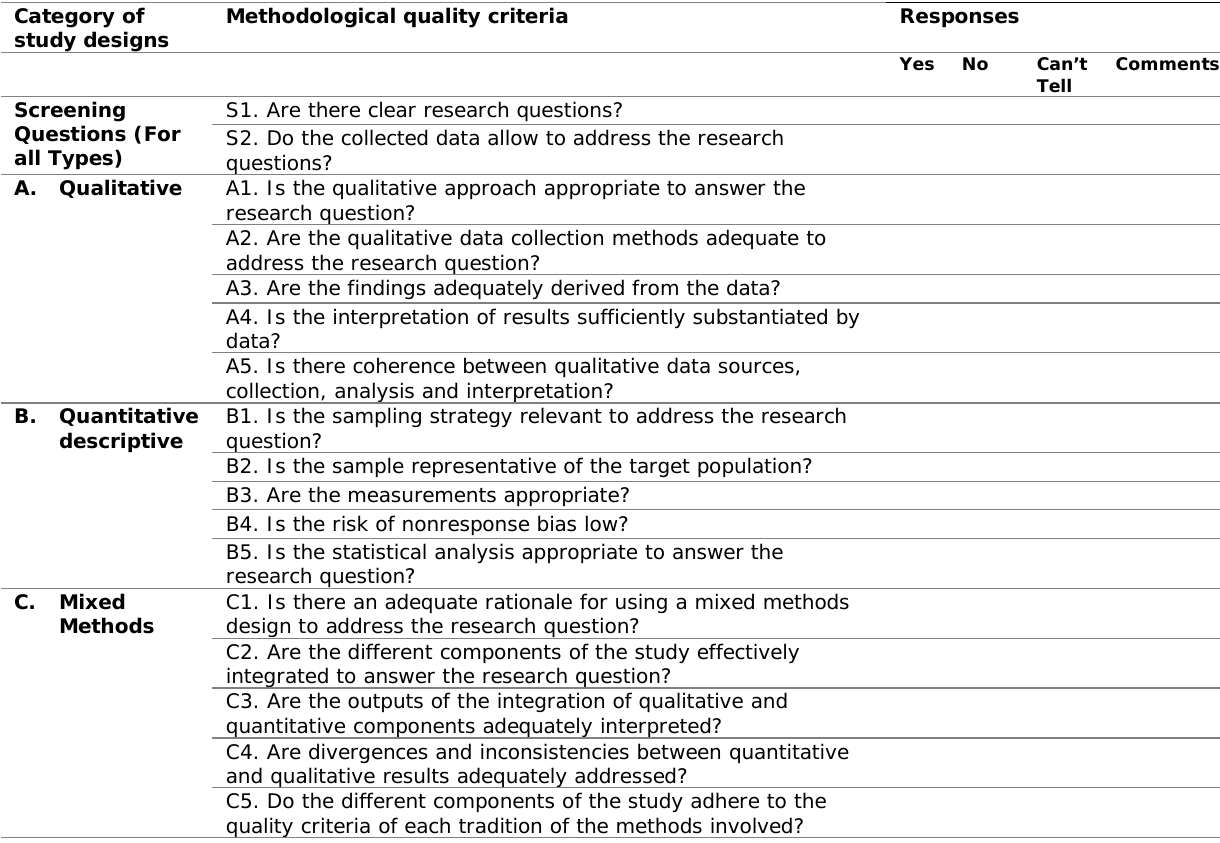
Table 3. Mixed Methods Appraisal Tool adapted from Hong et al. (2018) Category of study